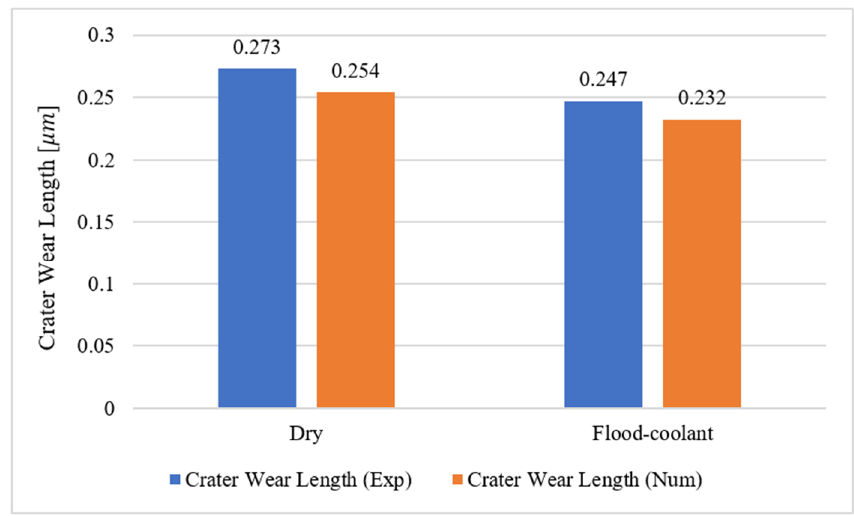
( c ) Ft Figure 16. Variation of cutting and thrust forces with time during flood-coolant orthogonal cutting: ( a ) in the experiment